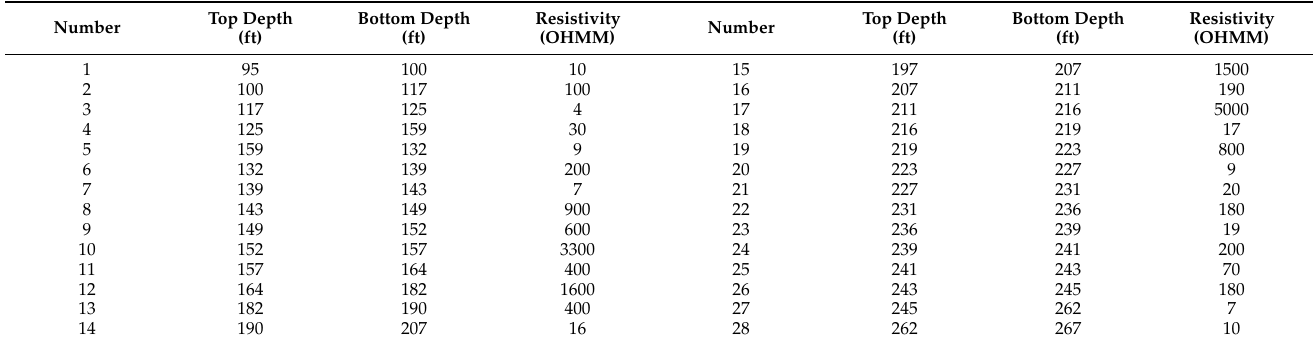
Table 1. Sets Oklahoma layer model parameter table (the relative dielectric constant is 100).